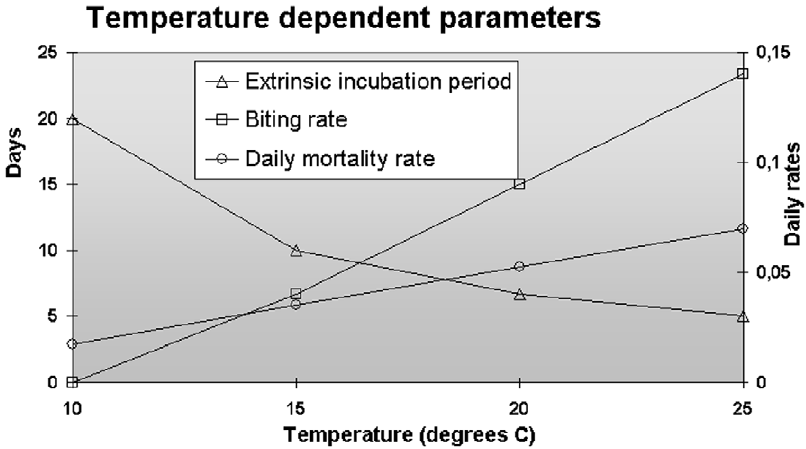
Figure 3. Relationship between temperature and known temperature-dependent parameters.